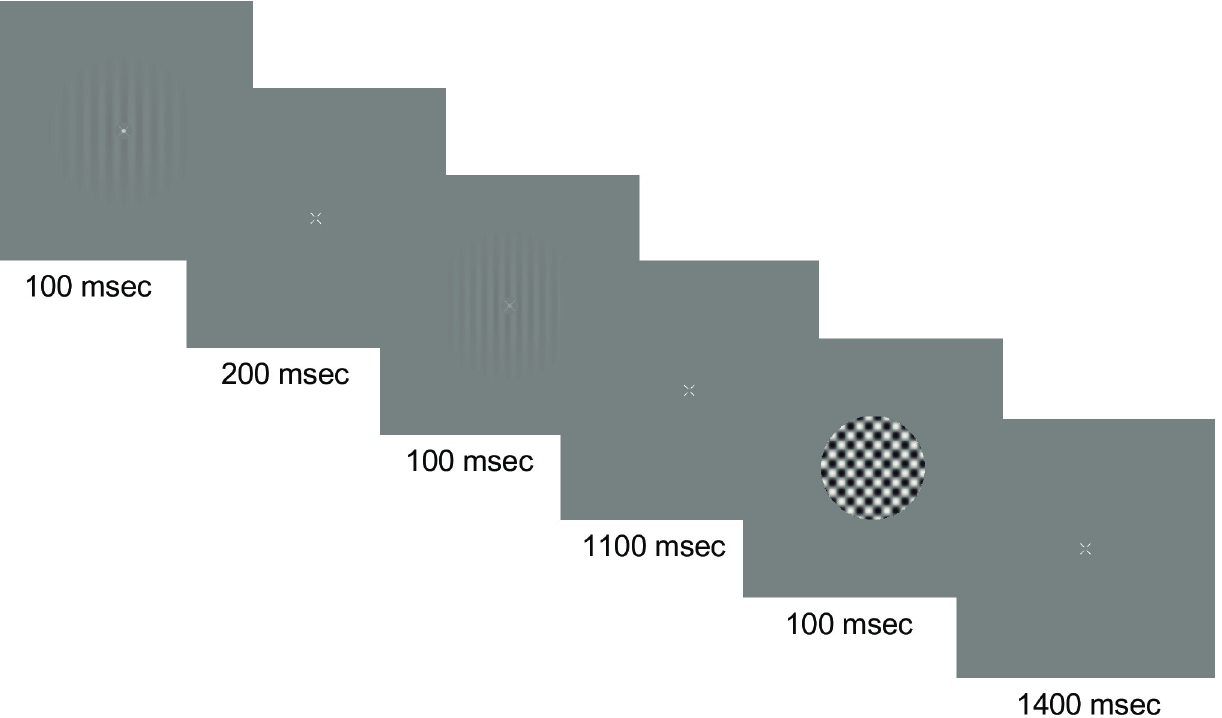
Fig 2. Stimulus sequence. In the main testing sessions, a secondary task trial was immediately followed by a TAE Task trial. For the secondary task, the two stimuli were each displayed for 100 msec with a 200 msec gap between and an 1100 msec response period. For the TAE Task a 100 msec test presentation was followed by a 1400 msec response